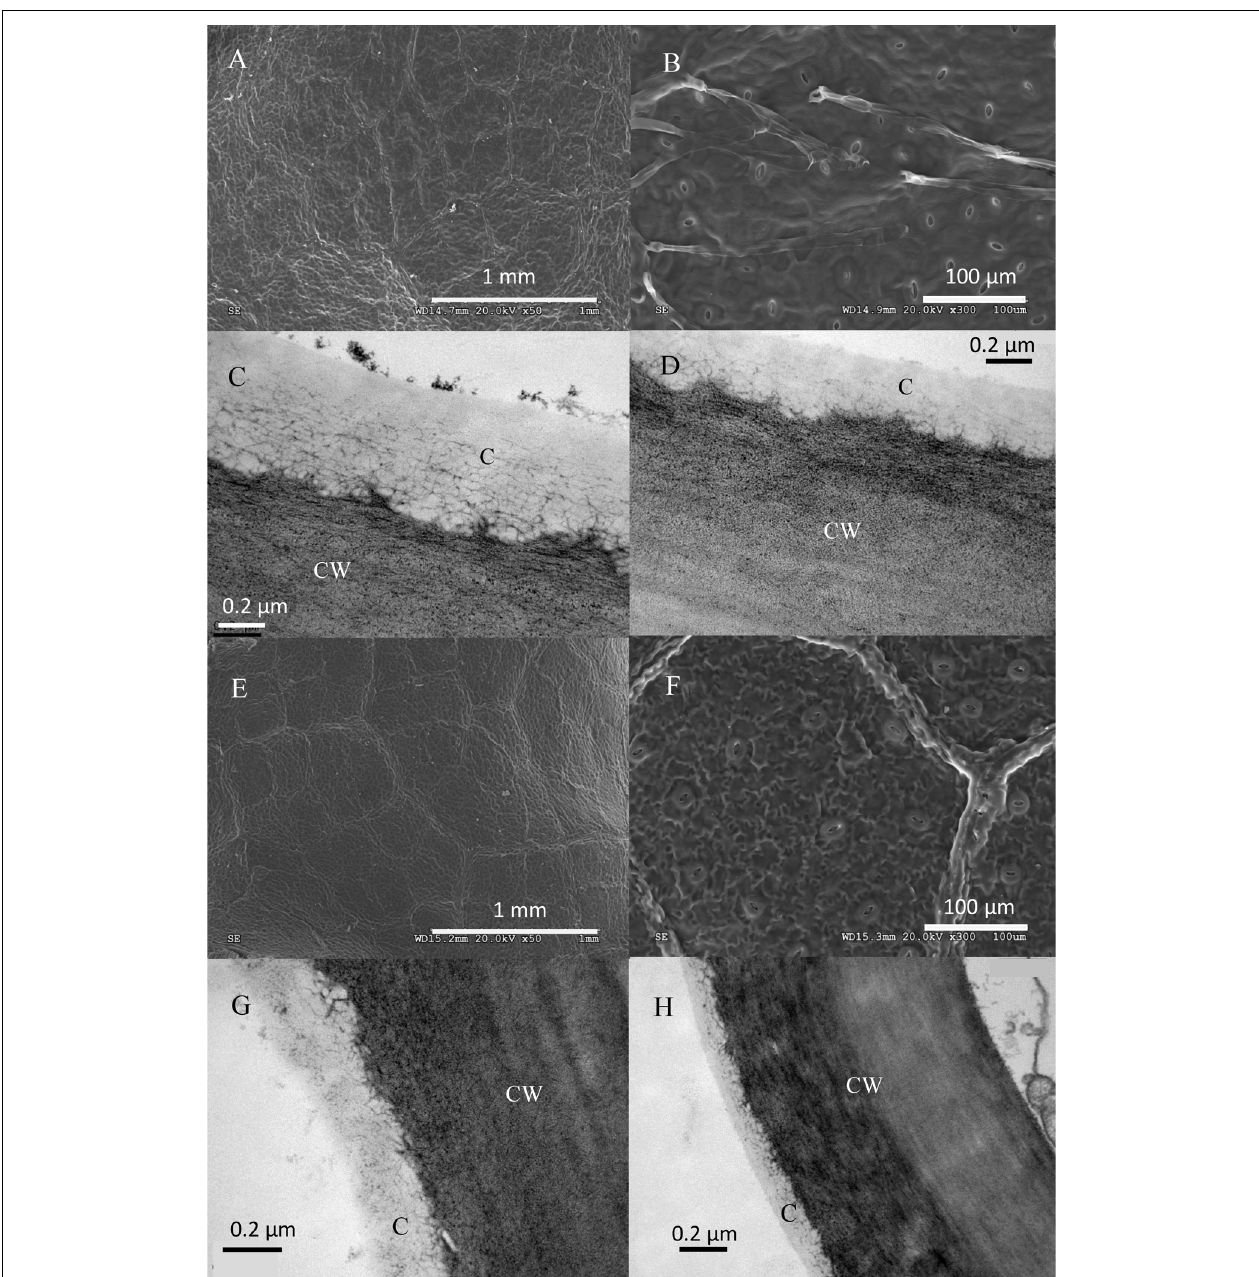
FIGURE 3 | Electron micrographs of adaxial and abaxial beech leaf surfaces. SEM images correspond to: (A) adaxial surface of an upper canopy leaf, (B) abaxial upper canopy leaf, (E) adaxial surface of a lower canopy leaf, (F) abaxial surface of a lower canopy leaf. TEM micrographs correspond to: (C) adaxial epidermis of an upper canopy leaf, (D) abaxial epidermis of an upper canopy leaf, (G) adaxial epidermis on a lower canopy leaf, (H) abaxial epidermis of a lower canopy leaf.